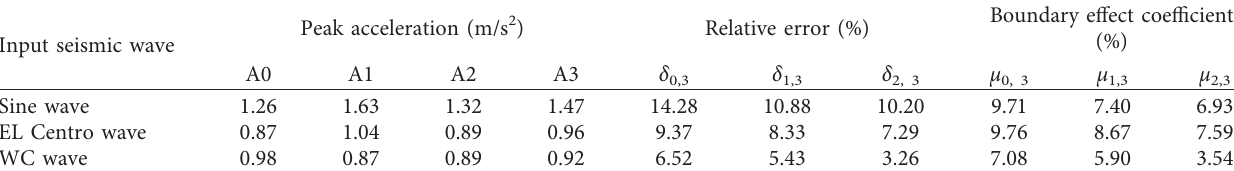
Table 5: Verification indicators of boundary